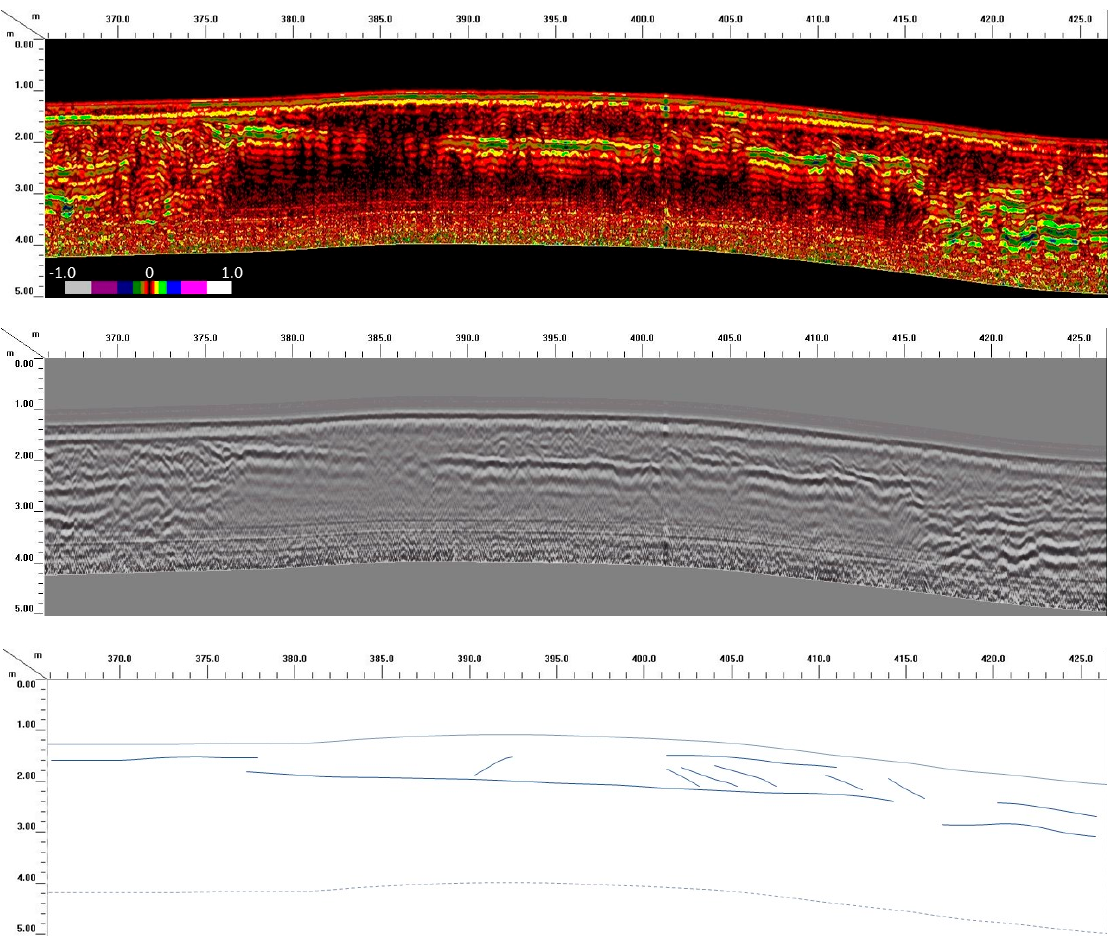
Figure 10. GPR profile and interpretation for the 1721 m shoreline. In the upper transect, data are presented with a color scale to highlight the normalized intensity of radar reflectors. The lower profile presents the same data in grayscale. In both profiles, landward is to the left and lakeward is to the right. Vertical exaggeration 3×.